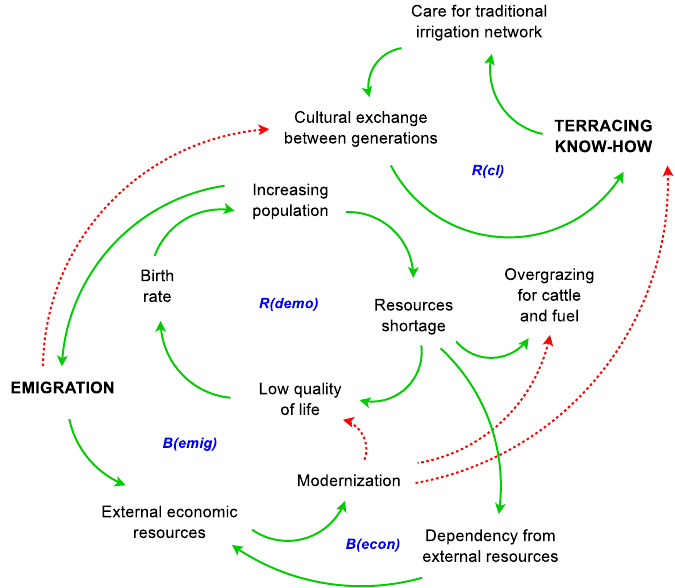
Figure 17. Archetype emerged by demographic, social and cultural dynamics mapped throughout Silverstein’s observation and integrated with direct observation of the effects on Assaragh TAS. R(demo) is a positive feedback cycle increasing population, R(demo) already today is weakened by two negative feedback cycles, the B(econ) of economic dependency from emigrants sending money to the village and the B(emig), a cycle linked to the increase of population inside the ksours . Nowadays these cycle are weakened, with respect to the past, but still active and are confirmed by demographic